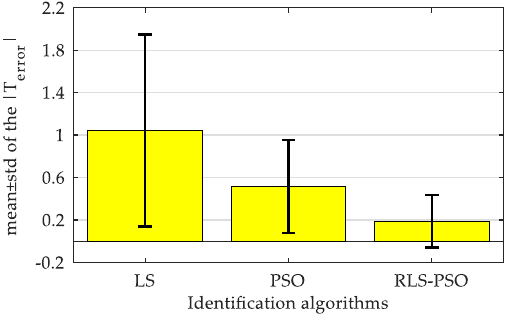
Figure 9. Measured torque, identified torque, and